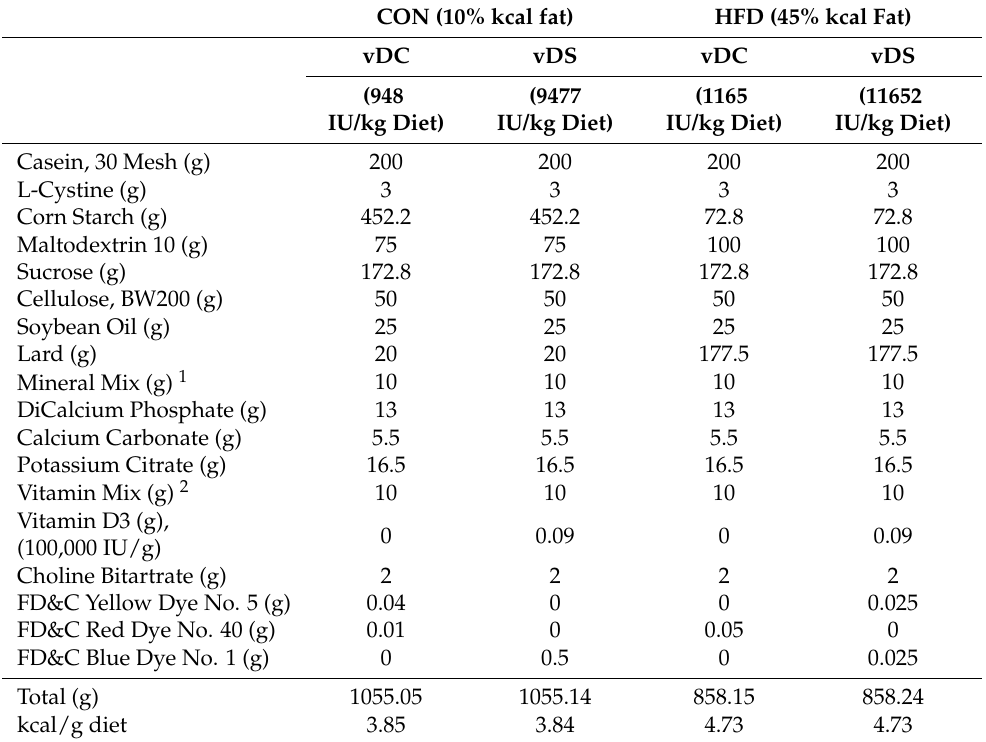
Resource: Research Diets, Inc., New Brunswick, NJ, USA; 1 10 g of Mineral Mix (Research Diets, Inc., #S10026) provides 1.0 g of Na, 1.6 g of Cl, 1.6 g of Mg, 0.33 g of S, 59 g of Mn, 37 mg of Fe, 29 mg of Zn, 6.0 mg of